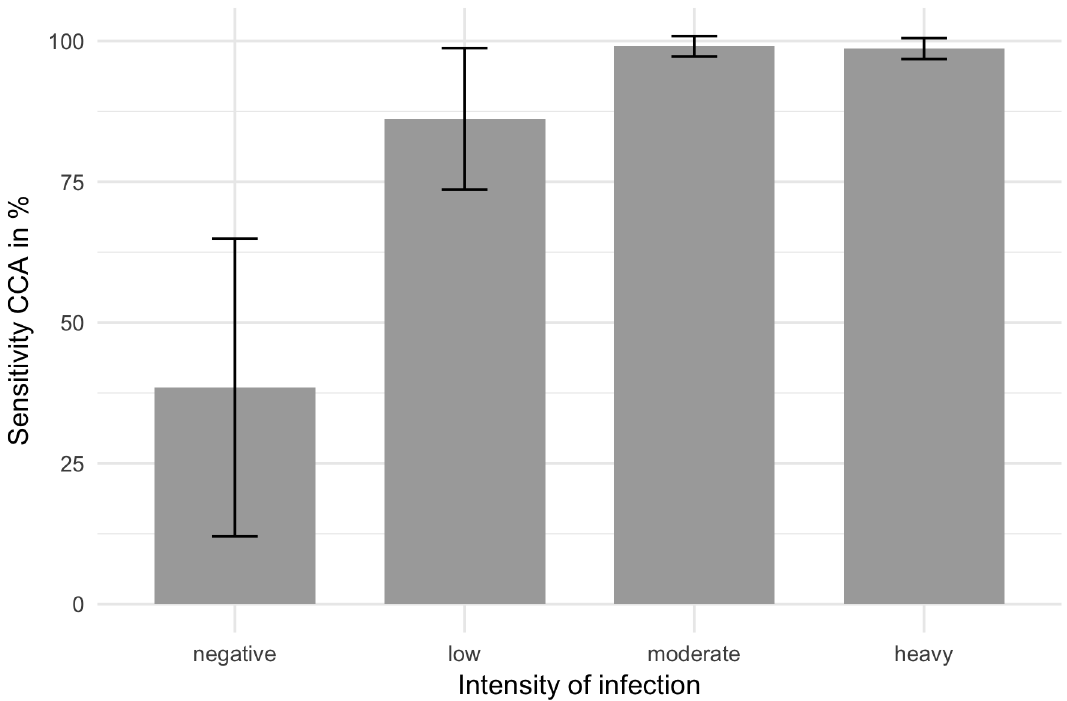
Fig 4. Sensitivity of Schistosoma POC-CCA urine rapid test and 95% intervals for the diagnosis of S . mansoni infections with low, moderate or high intensities determined by egg counts in stool or threshold cycle (Ct) values of real-time PCR results. Low intensity infection: KK 1–99 eggs per gram faeces (EPG) or Ct-value of real-time PCR > 30. Moderate intensity infections: KK 100– 399 EPG or Ct-value < 30. High intensity infection: KK > 400 EPG and Ct-value of real-time PCR < 30. The specificity of POC-CCA test amounts to